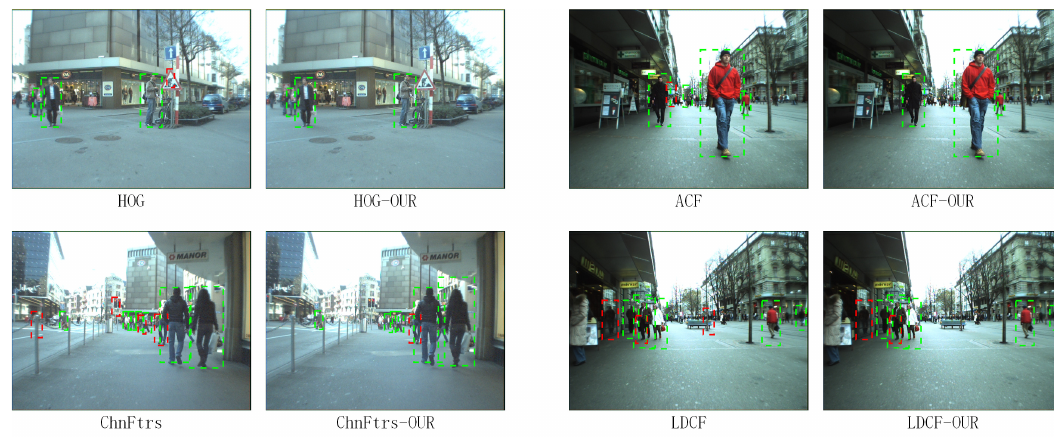
Figure 15. Results on the ETH Pedestrian